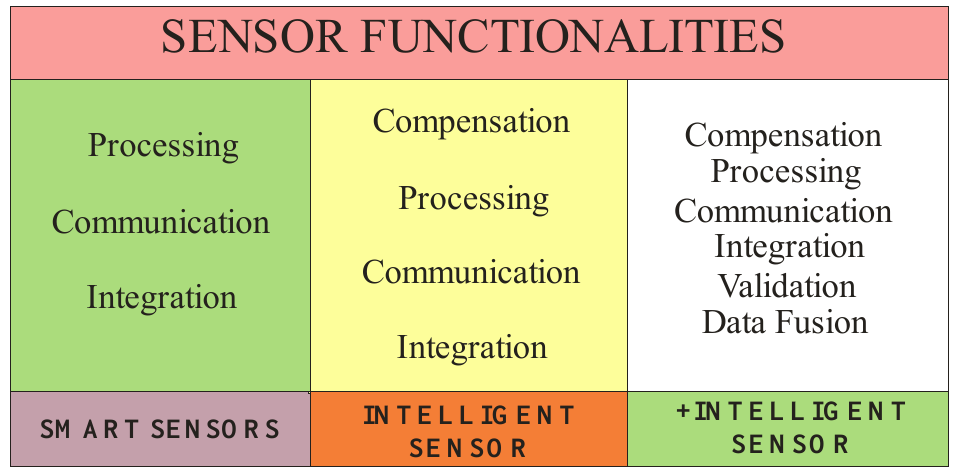
Figure 1. Intelligence Sensors classification base on its